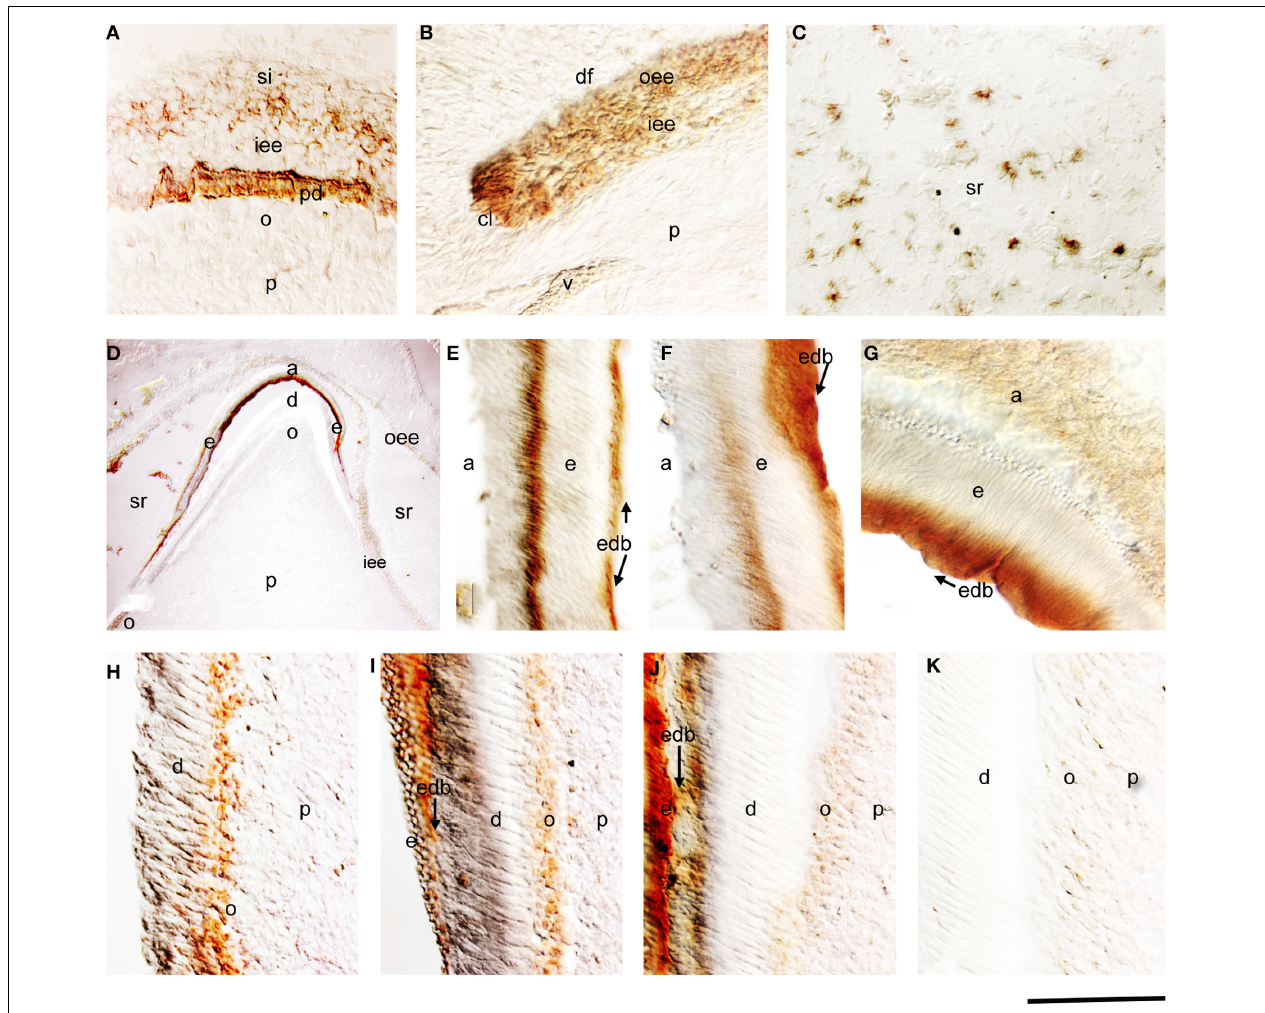
FIGURE 1 | Amelogenin immunostaining in developing deciduous human teeth. (A) Cusp area of a deciduous human molar at the early bell stage of development (18g.w.). Amelogenin is detected in cells of the inner enamel epithelium (iee) and stratum indermedium (si) overlying the predentin (pd), which is also positive for amelogenin protein. (B) Cervical loop area of a deciduous human molar (18g.w.). Amelogenin immunoreactivity is evident in cells of the outer enamel epithelium (oee) and iee. (C) Amelogenin staining in some cells of the stellate reticulum (sr) of a 18g.w. deciduous human molar. (D) Cusp area of a deciduous human first incisor at the late bell stage of development (30g.w.). Strong amelogenin staining is found in enamel (e). A weaker amelogenin